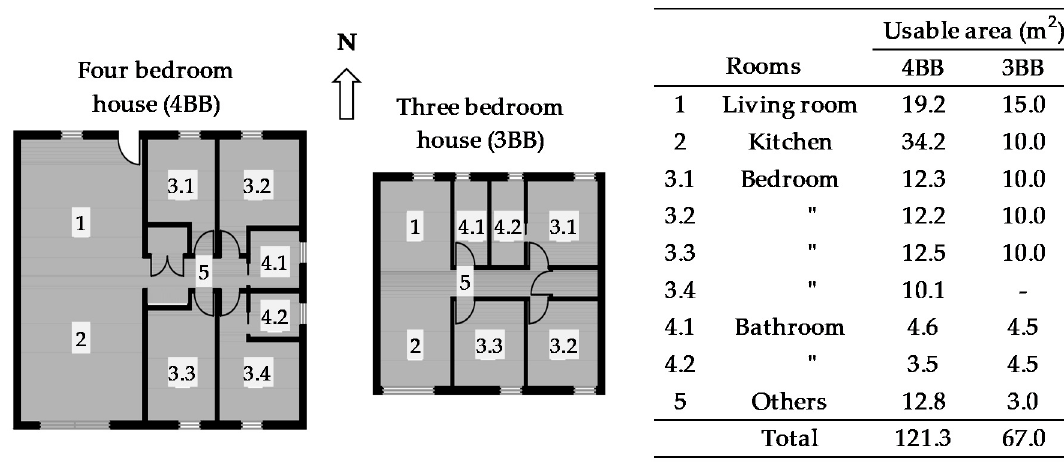
Figure 2. House layout: four-bedroom building (4BB) and three-bedroom building (3BB). Table 1 shows parameters that define the thermal performance of the windows.